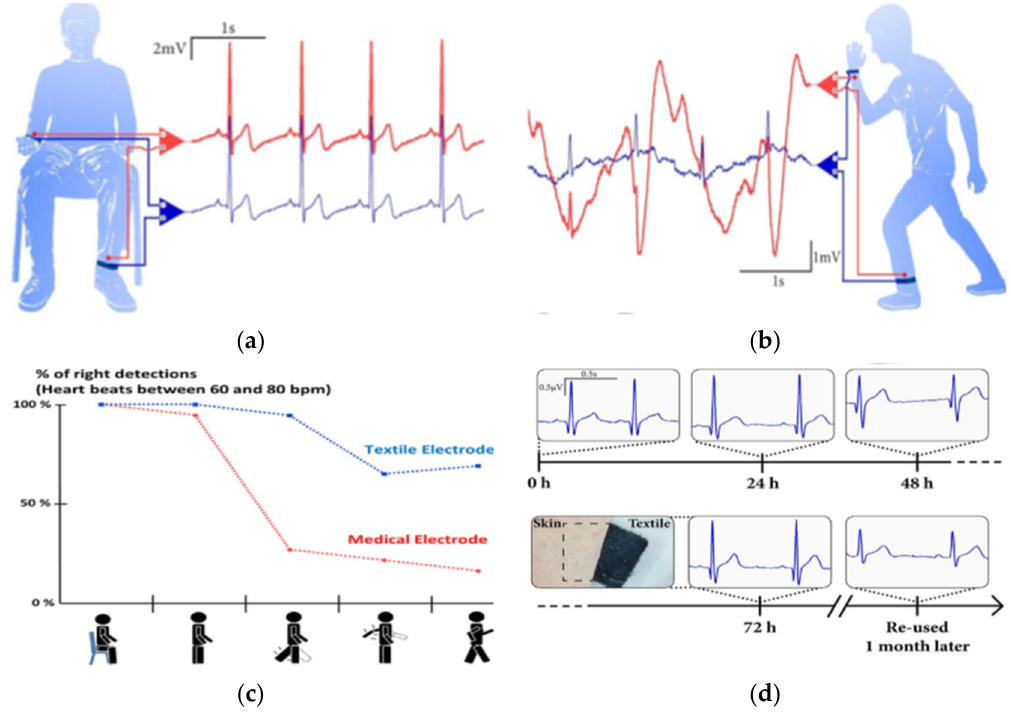
Figure 8. ECG recordings performed with the PEDOT:PSS/IL textile electrode (in blue), and Ag/AgCl electrode (in red): ( a ) from volunteers sitting at rest; ( b ) during movement; ( c ) percentage of the accuracy of heartbeat detection during different types of activity (seating, standing up, leg moving, arm moving, walking) with textile and Ag/AgCl electrodes; and ( d ) ECG signal evolutions obtained with textile electrodes in permanent contact with the skin over three days. The inset shows a picture of the skin under the electrode after 72 h. The last ECG signals were obtained from re-used textile electrodes stored in ambient air for one month, adopted from